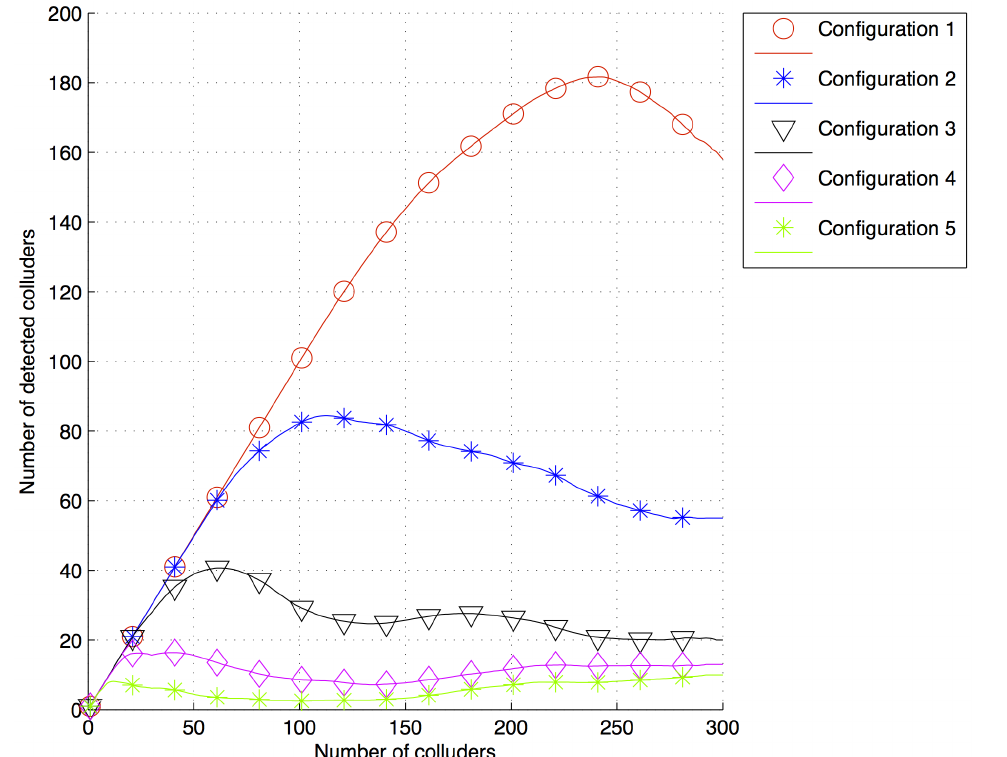
Figure 4. Number of detected colluders after a collusion attack for fingerprints generated with the configurations 1, 2, 3, 4 and 5 in Table 3 and P w ~ 1 = 6